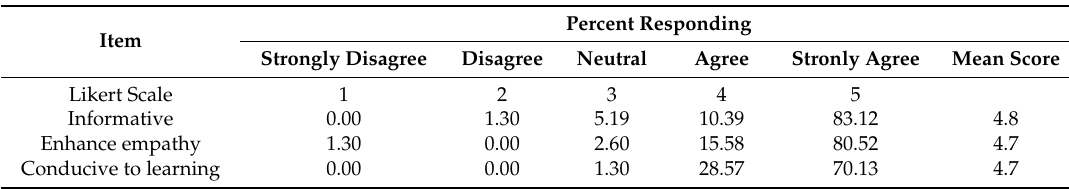
Figure 1. Quantitative representation of the student evaluation data of the interactive session with respect to ( A ) usefulness of the learning objectives, ( B ) relevancy and interest, and ( C ) structure and execution. The students evaluated the activity, which contained eleven Likert scale questions (five choices are shown) regarding these aspects. Table 5. Quantitative presentation of students’ responses to the involvement of patients in the gastroenterology